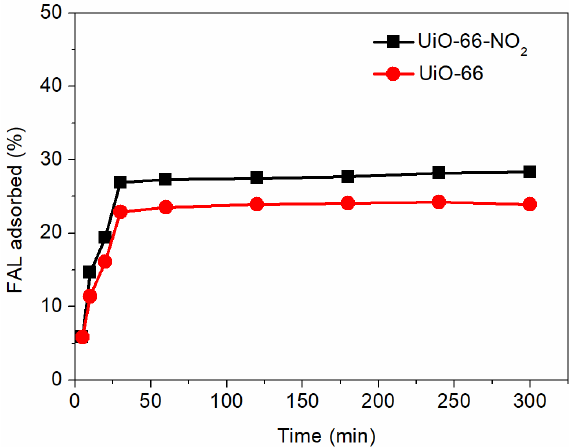
Figure 5. Variation of adsorbed FAL with time in static adsorption.